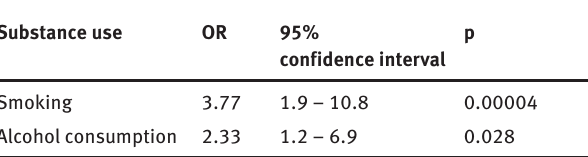
Table 9: Chance of getting ovarian cancer depending on the usage of drugs.